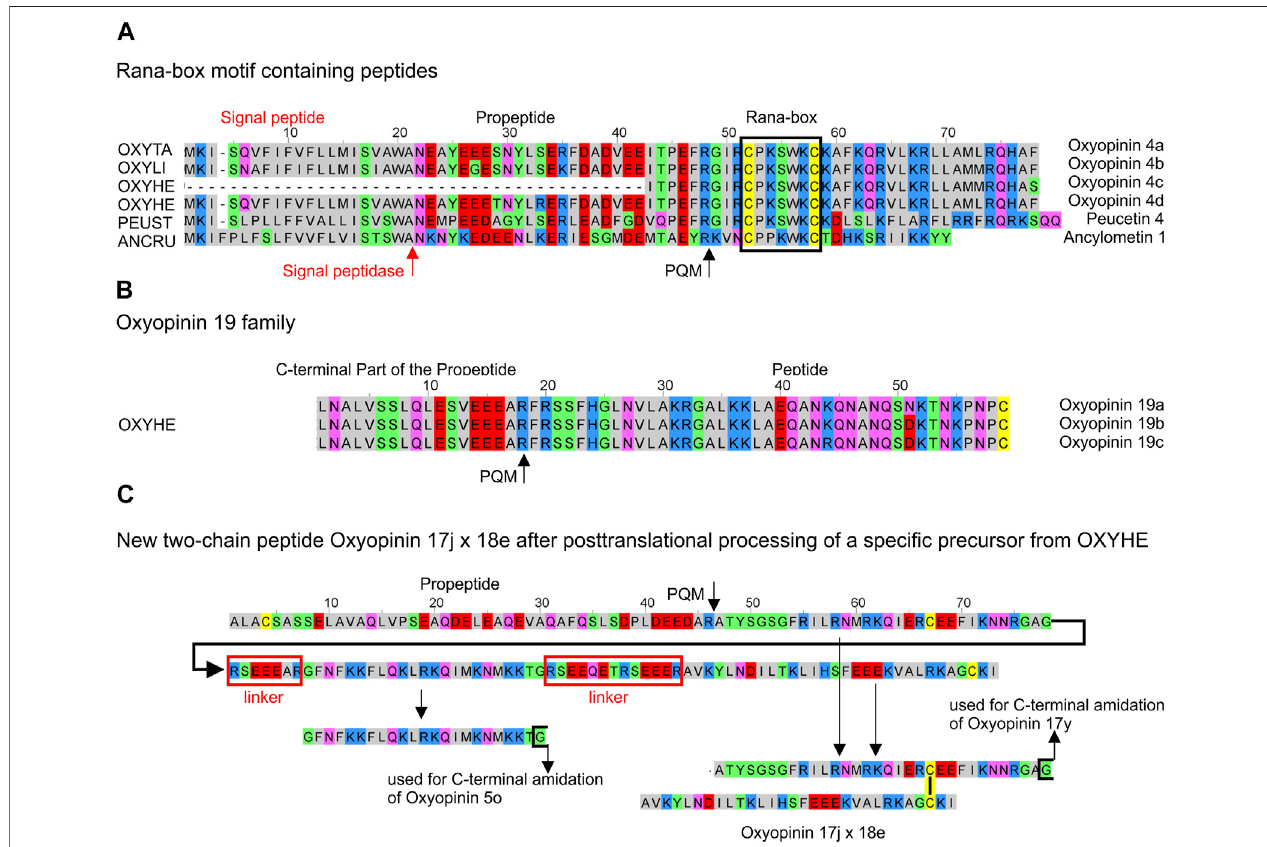
FIGURE 7 | Overview of cysteine containing LPs identi fi ed in the venom gland transcriptomes of ctenids and oxyopids. (A) Rana-box like peptides identi fi ed in oxyopidssuchas Oxyopestakobius [F8J4S0,OXYTA], O.lineatus [OXYLI], O.heterophthalmus [OXYHE], Peucetiastriata [PEUST],and inthectenid Ancylometesrufus [ANCRU]. (B) Oxyopinin 19a, b, c with C-terminal Cys from O. heterophthalmus [OXYHE]. (C) Hypothetical processing of speci fi c precursors identi fi ed in O. heterophthalmus [OXYHE] resulting in oxyopinin 5o and the two-chain peptide oxyopinin 17j x oxyopinin 18e. Cationic amino acids are colored in blue, anionic amino acids in red, the corresponding C-terminal amid variants in pink, hydrophobic amino acids in black, Cys in yellow, and polar amino acids in green.